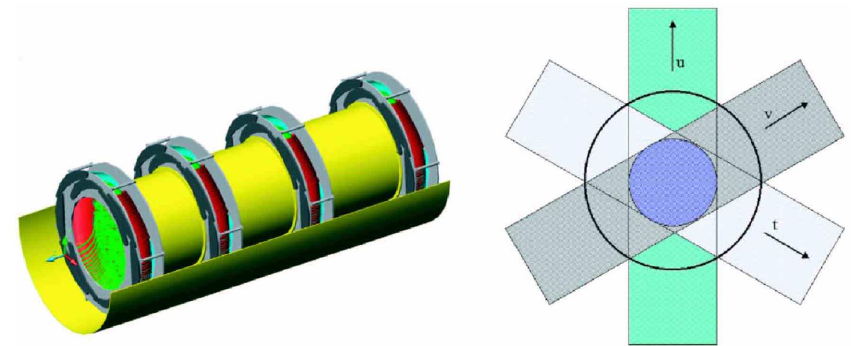
FIG. 48. (Color) A possible MICE tracking-detector configuration.